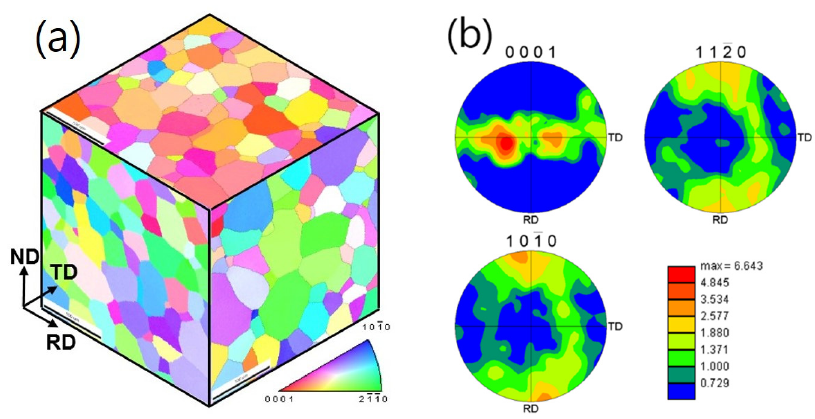
Figure 2. EBSD (electron backscatter diffraction) investigation for the initial microstructure: ( a ) inverse pole figure map from the 3-dimensional view and ( b ) pole figures with respect to (0001), (11 − 20), and (10 − 10).